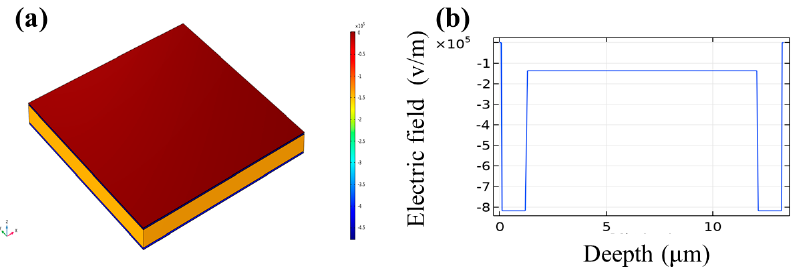
Figure 7. ( a ) The electric field distribution simulation result for the PTFE–c–PVDF composite film. ( b ) The electric field distribution simulation result of the cross-section along the normal direction.